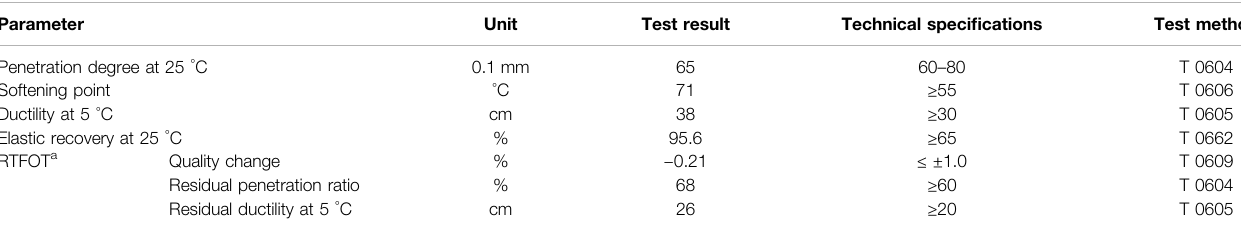
TABLE 1 | Performance indices and test results of SBS modi fi ed asphalt.